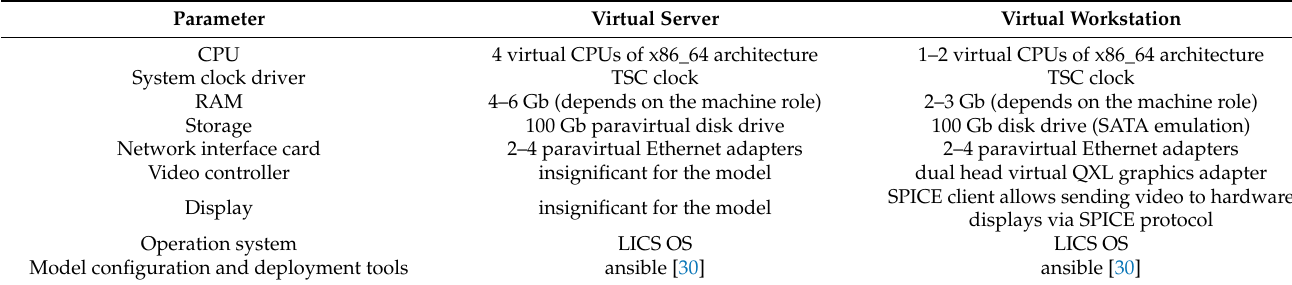
Table 5. Parameters of virtual